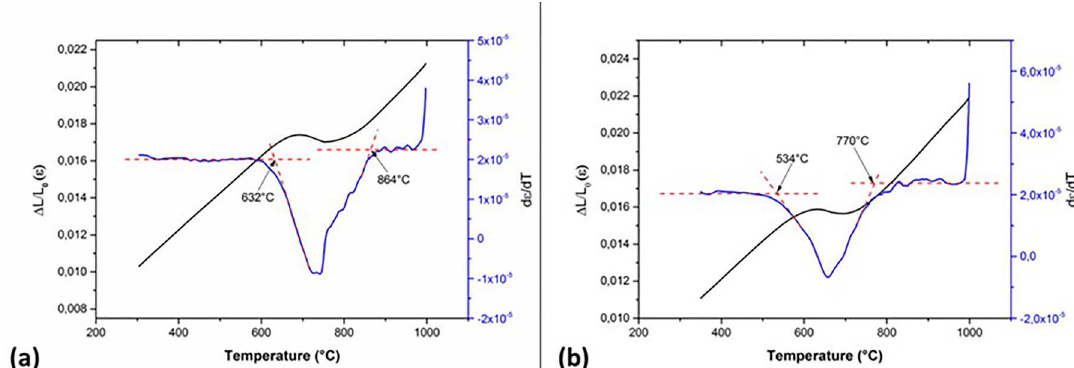
and Ar temperatures from studied steels: (a) steel A, (b) steel B. 3 1